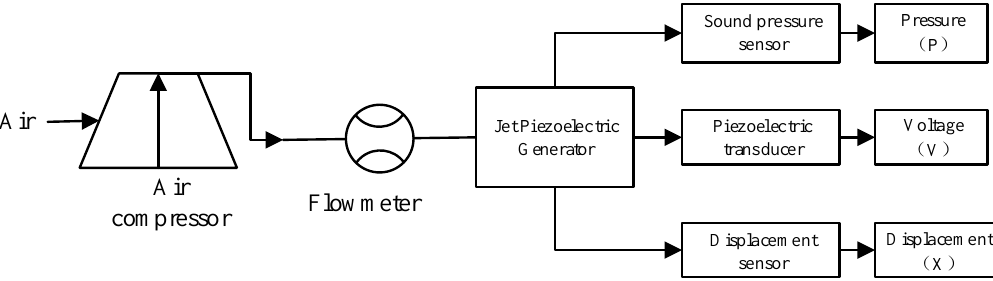
Figure 4. Blowing simulation test process.